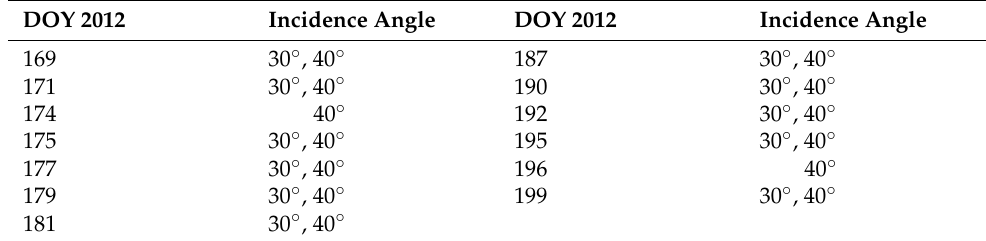
Table 4. Characteristics of UAVSAR data over the study area.